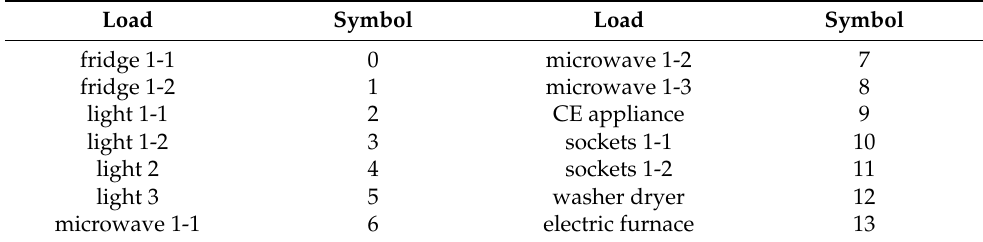
Table 1 below: 1-1, 1-2 denote different states of the same device and electric light 2 and electric light 3 denote two different light loads. Table 1. Symbols representing the load of the REDD dataset.